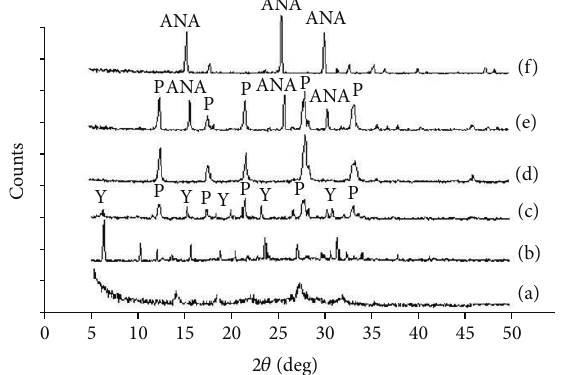
Figure2:X-raypatternsofsynthesizedzeolitesatdifferenttempera-